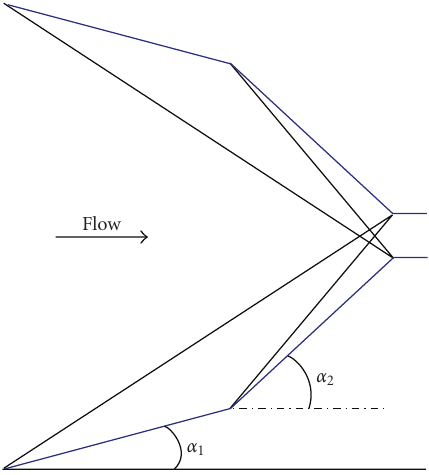
Figure 1: Symmetric double ramp full inlet.